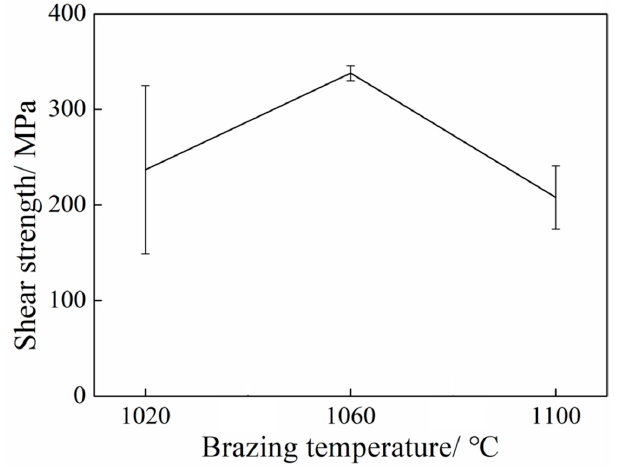
Figure 6. Shear strength of the DD98M-DD98M joints brazed at different temperatures for 30 min.